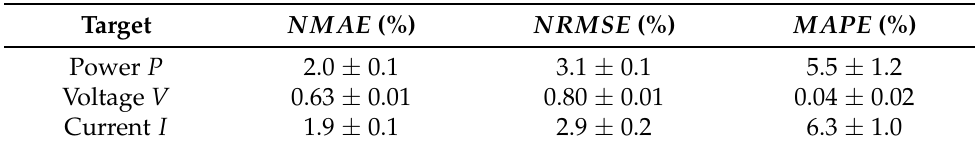
Figure 3. Comparison of the simulation of the current for the healthy Ref wind turbine, with and without PCA. Table 3. Average error metrics and standard deviations for the 10-fold cross validation on the D test data set: PCA model.